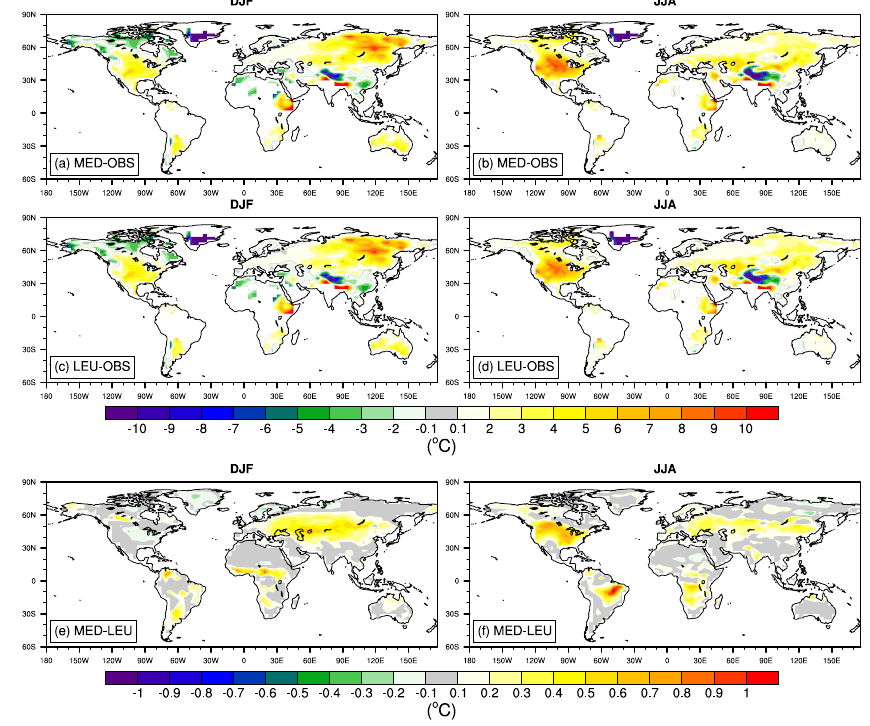
Figure 3. Same as in Fig. 2 except for minimum temperature ( T MIN